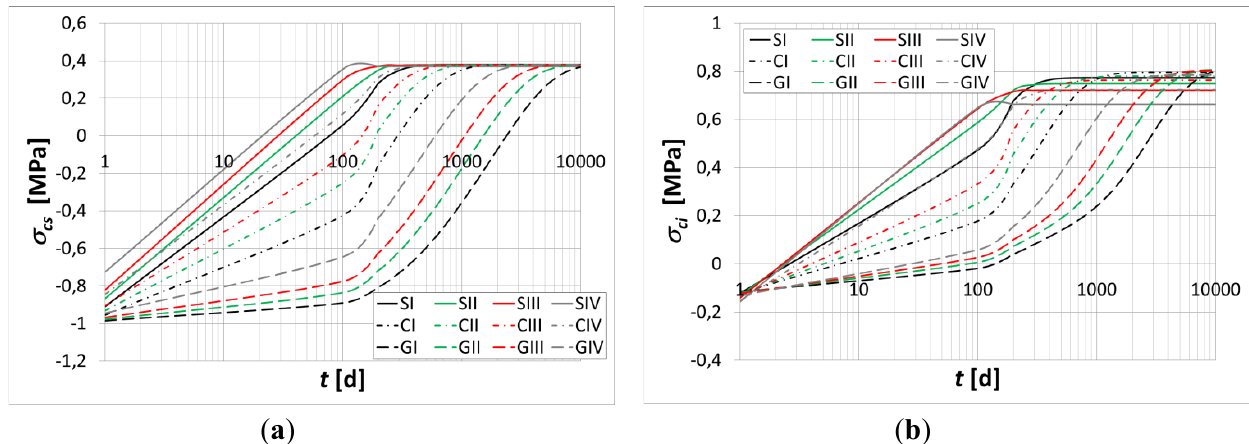
Figure 5. ( a ) Instantaneous stresses at the top fiber of the beam; ( b ) Instantaneous stresses at the bottom fiber of the